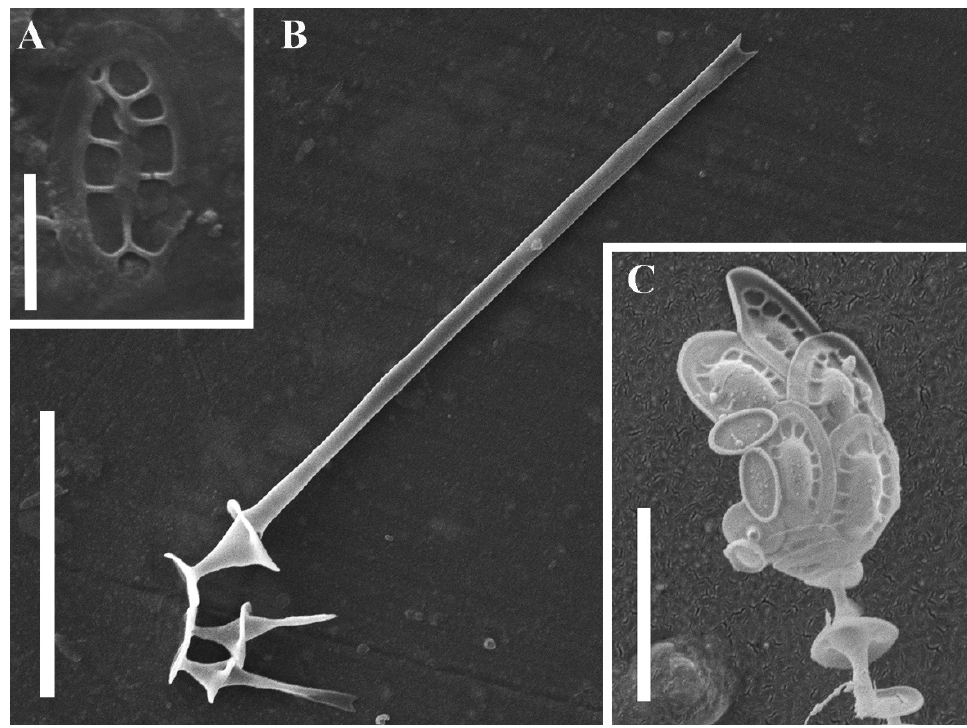
Figure 2. ( A – C ) Chrysosphaerella longispina from the Moscow Region, SEM. ( A ) Oval plate-like scale; ( B ) spine-like scales of different size classes; ( C ) a part of the cell armor consisting of the patterned and unpatterned oval plate-like scales and the spine-like scale. Scale bars: ( A ): 2 µm; ( B ): 10 µm; ( C ): 5 µm. Table 2. Morphometrical comparison between Chrysosphaerella septentrionalis and C. longispina (incl. C. multispina